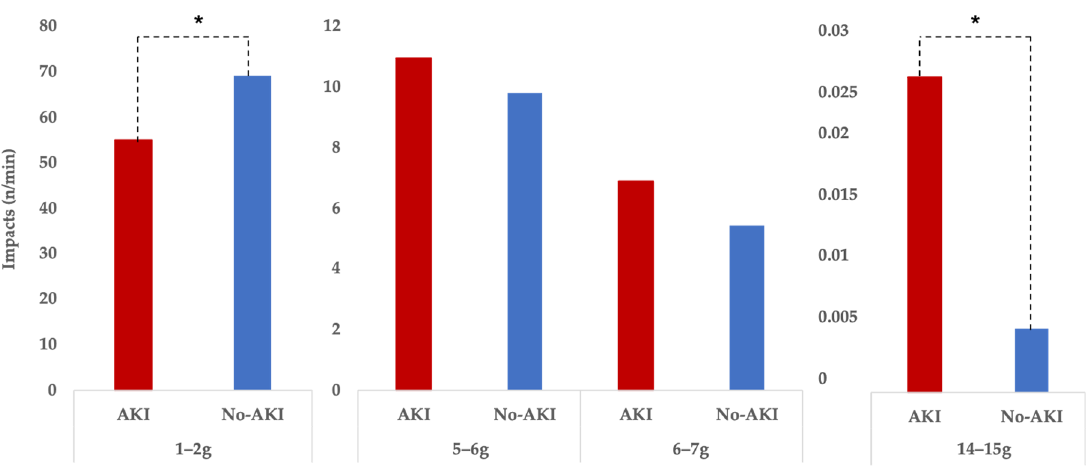
Figure 4. Differences between runners showing signs of AKI ( n = 6) and those showing no signs of AKI ( n = 12) regarding impacts per minute, grouped in four impact g-force categories. * The biggest difference between the AKI and no-AKI group is that the no-AKI group managed to run “smoother,” keeping impacts in the lower impact load ranges, while avoiding higher impacts loads.